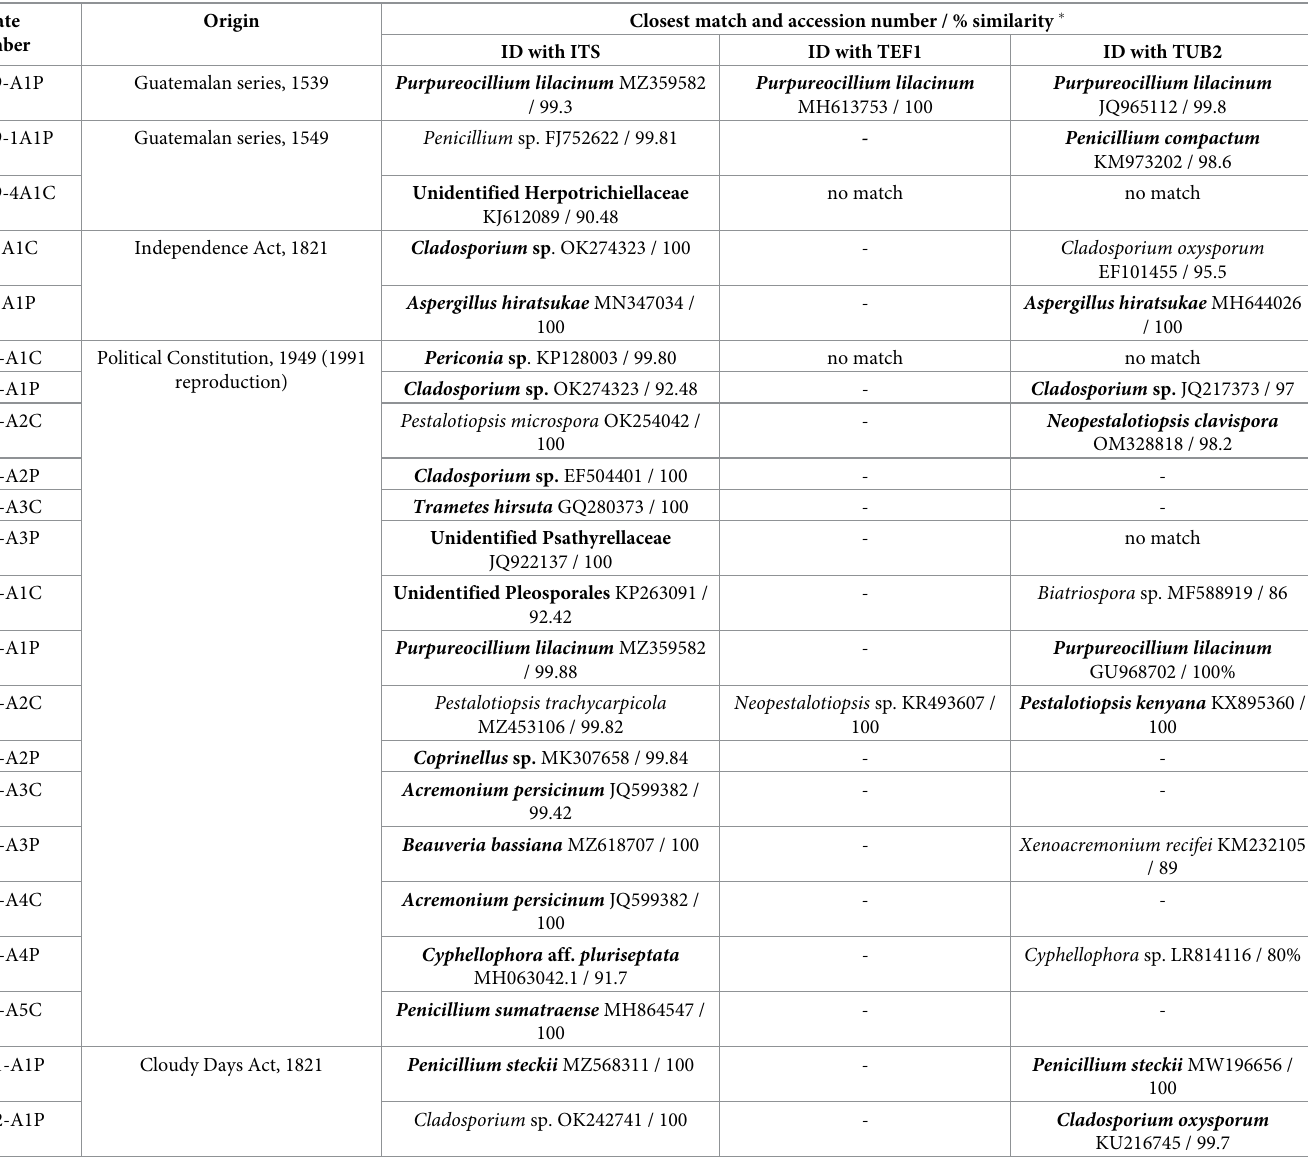
Table 2. Identification (ID); BLAST results using ITS, TEF1 and TUB2; and origin of documents. Names in bold indicate the assigned/selected classification. Isolate